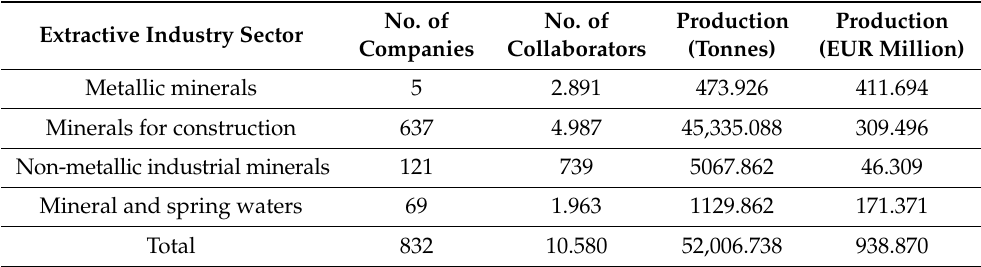
Table 3. Characterization of the extractive industry in Portugal.